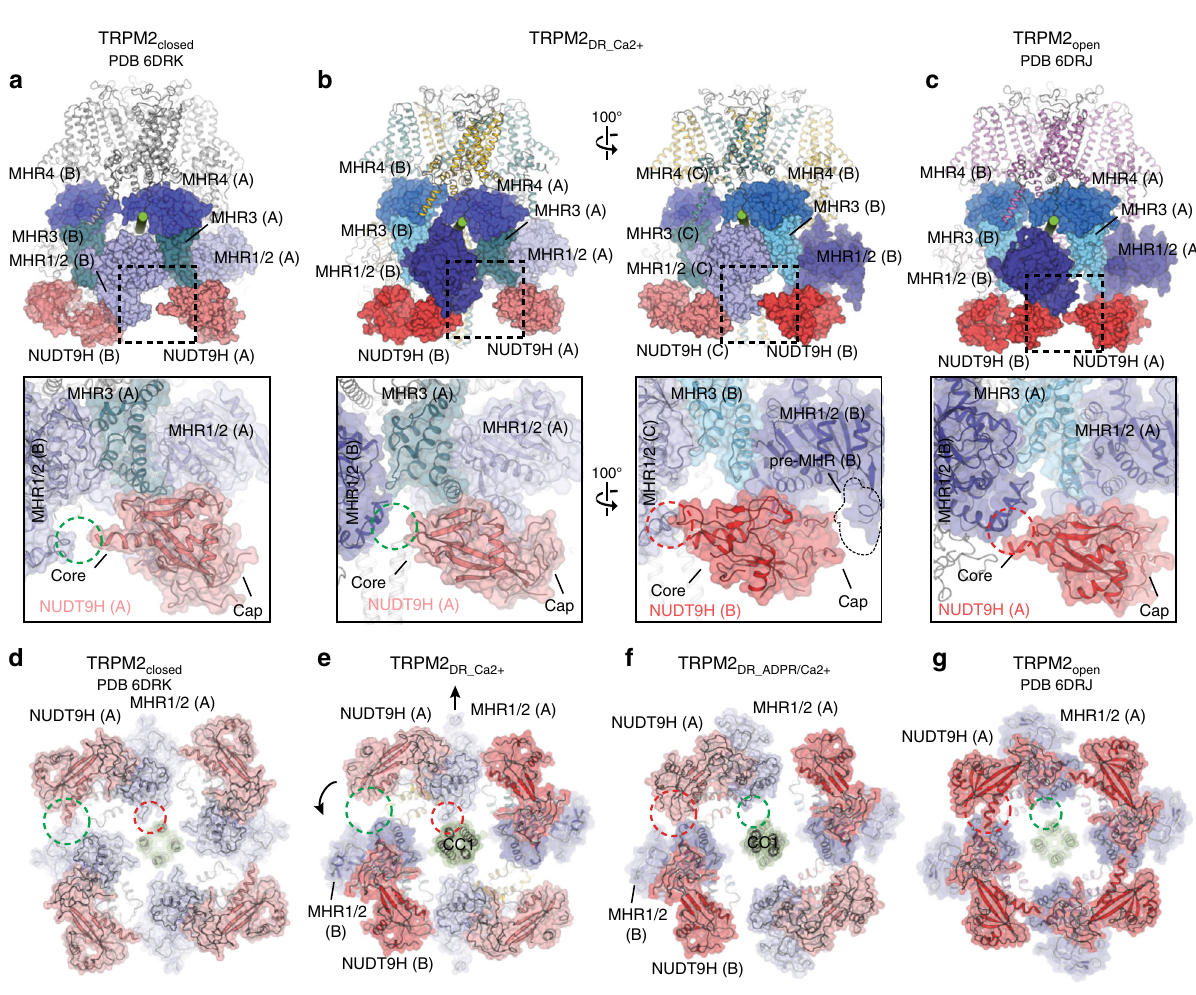
Fig. 6 Alternating quaternary structure rearrangements in the cytoplasmic domain (CD). Comparison of the interaction networks between the NUDT9H domain and the neighboring MHR1/2 domain in the TRPM2 closed ( a , PDB 6DRK), TRPM2 DR_Ca2 + ( b ), and TRPM2 open ( c , PDB 6DRJ) structures, respectively. Close-up views show that the NUDT9H domain in the TRPM2 closed structure makes contact solely with MHR1/2 from the same subunit ( a ), while the core subdomain of the NUDT9H in the TRPM2 open structure ( c ) makes additional interactions with the MHR1/2 from the adjacent protomer. More importantly, the TRPM2 DR_Ca2 + structure adopts both interactions mediated by the NUDT9H and MHR1/2 domains ( b ). Viewed from the intracellular side, cartoon and transparent surface representations compare the conformational changes at the bottom layer of the CD in the TRPM2 closed ( d ), TRPM2 DR_Ca2 + ( e ) and TRPM2 DR_ADPR/Ca2 + ( f ) from the current study, and TRPM2 open ( g ) structures, respectively. Arrows indicate the domain movements observed in the TRPM2 DR_Ca2 + ( e ) and TRPM2 DR_ADPR/Ca2 + ( f ) structures relative to the channel in the closed conformation ( d ) and en route to the open conformation ( g ). Dashed circles highlight the detachment (green) and association (red) between the different domains as a result